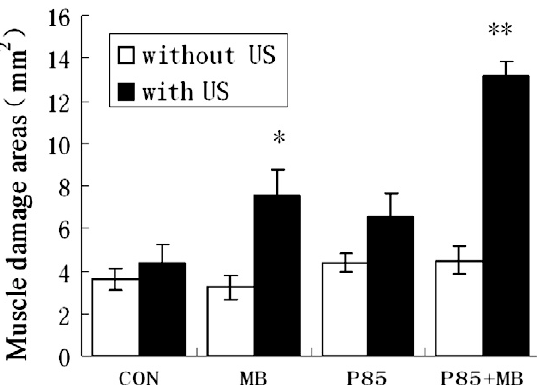
Figure 5. Sizes of the regions of damaged muscles. Both * and ** indicate comparisons between groups and saline control. * indicates p < 0.05 and ** p < 0.01. Data are presented as mean ± s.d. (two-tail Student’s t-test, Microsoft Excel 2003). (Reprinted from Chen et al. [18] with permission.)